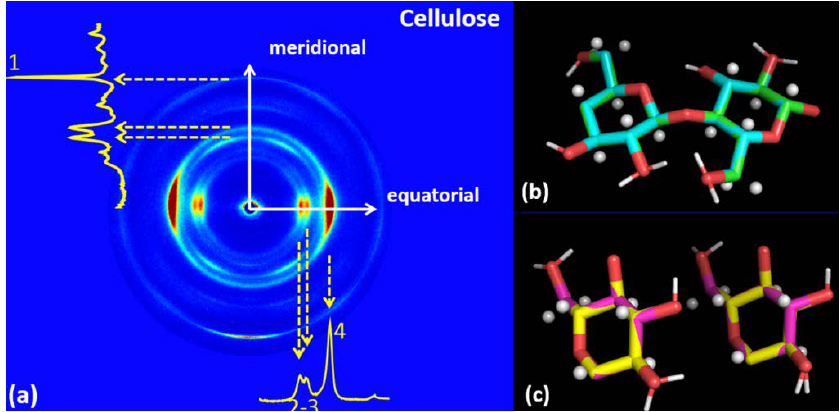
Figure 5. ( a ) Two-dimensional WAXS fiber diffraction pattern collected on cellulose [46], with white arrows along the fiber axis (meridional) and perpendicular to it (equatorial). The corresponding 1D WAXS integrated profiles show the main peaks of the protein, i.e., the meridional peak (marked as 1) and the equatorial peaks (marked as 2, 3 and 4), respectively; ( b ) I α model; ( c ) I β model.